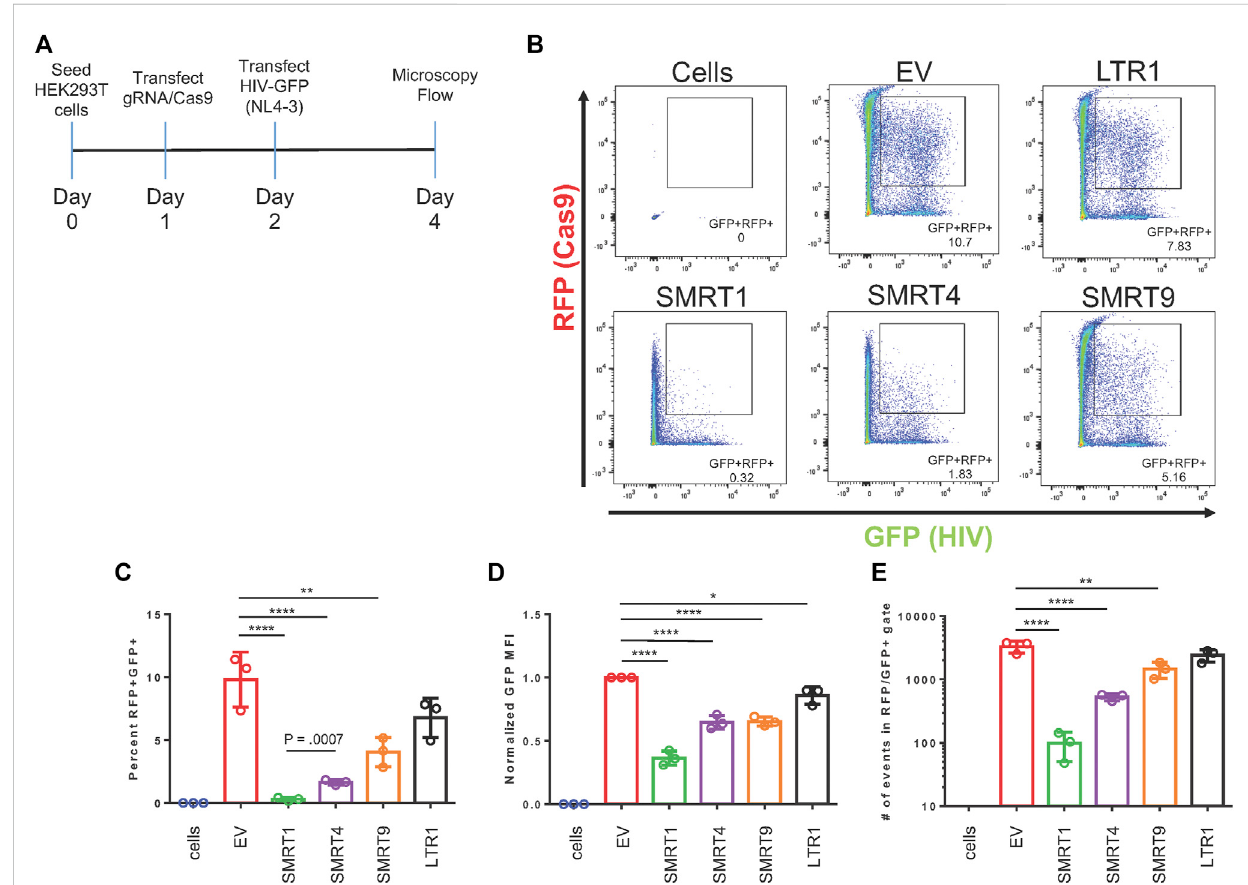
FIGURE 2 gRNAs targeting TAR have the greatest effect on LTR-mediated HIV-1 gene expression. HEK-293T cells were transfected with the all in one Cas9vector systemthat also expressedthegRNAand RFP.Twentyfour hours posttransfection,an NL4-3 GFPmolecular clone, referred to as HIV-1 GFP was transfected into the same cells. Forty eight hours after transfection with Cas9, cells were processed for fl ow cytometry. (A) A schematic representation of the experimental timeline. (B) Representative FACS plots of detecting double-positive cell populations (RFP + GFP+). Double- positive events are shown in thegated box.EV =empty vector, expresses Cas9and RFP with nogRNA. Cells areHEK-293Tcells that wereuntreated with anyplasmid. (C) Quantitativeanalysisofgatedcellpopulations(GFP+RFP+), (D) Mean fl uorescentintensity(MFI)ofGFPfromdouble-positivegatedcells, (E) totalnumberofeventsinthedouble-positivegate.Errorbarsrepresent±SD.Statisticalsigni fi cancewasdeterminedbyusingaOne-wayANOVAwith multiplecomparisons. p =* < .05,** < .01,*** < .001,**** < .0001.Datawascollectedfromthreeindependent experiments.50,000 eventswerecollected from each treatment